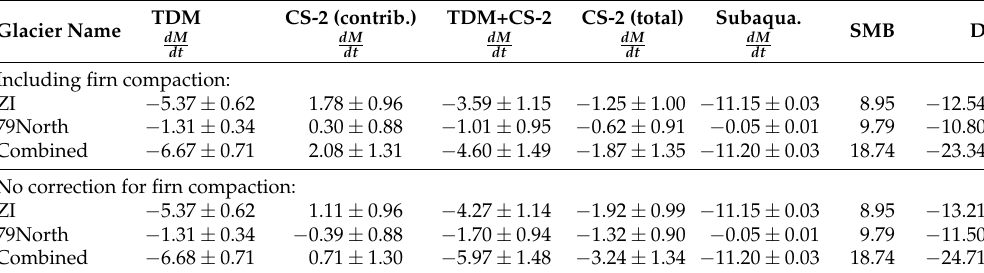
Table 3. dM estimates from the TDM/CS-2 combination for Zachariæ Isstrøm and 79North in the dt time period between 01/01/2011 and 31/12/2013 with and without contributions of the modelled firn compaction rate from the IMAU-FDM model [51]. The CS-2 (total) mass change was calculated for the entire basin while CS-2 (contrib.) only states the mass change for the area that contributes to the combined estimate (TDM+CS-2). The total mass loss is calculated excluding sub-aqueous mass change. The ice discharge D is calculated from the difference between the volumetric mass balance and modelled SMB (RACMO2) [62]. Units are Gta − 1 .